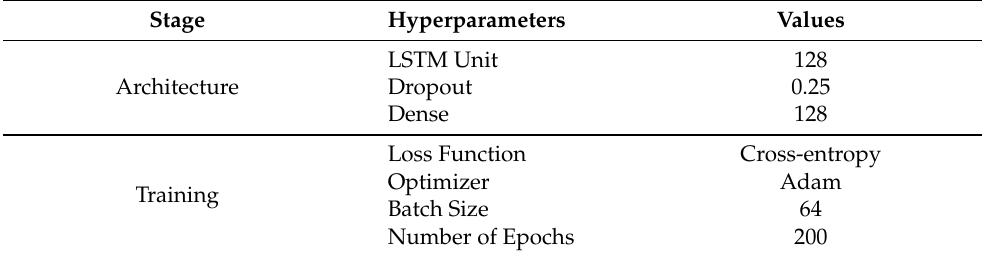
Table A2. The summary of hyperparameters for the LSTM network used in this work.